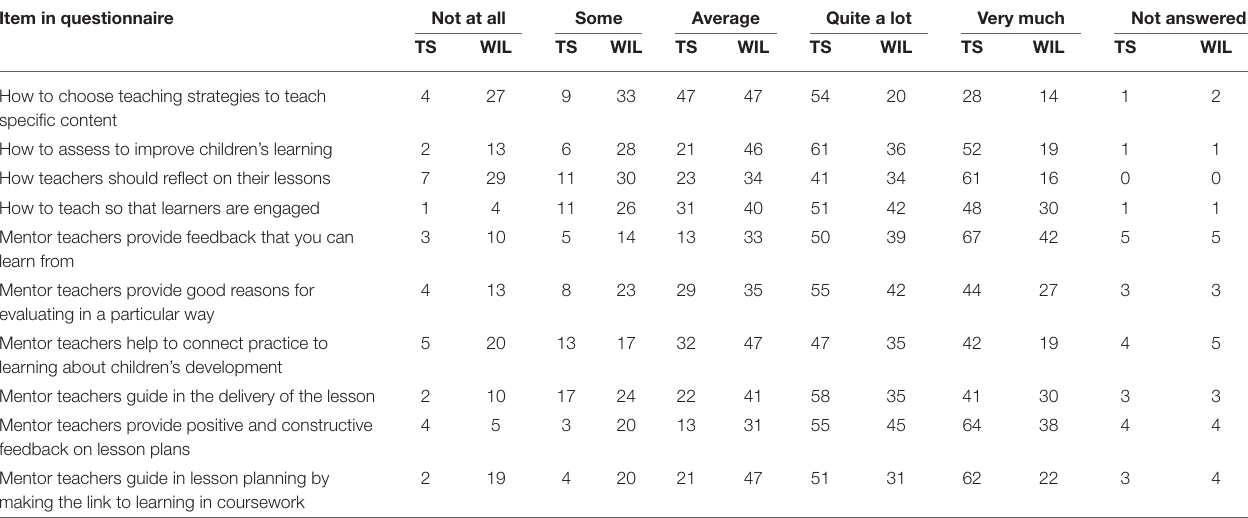
TABLE 1 | Frequency of responses: how much student teachers ( n = 143) learned in the teaching school (TS) and WIL schools, respectively. Item in